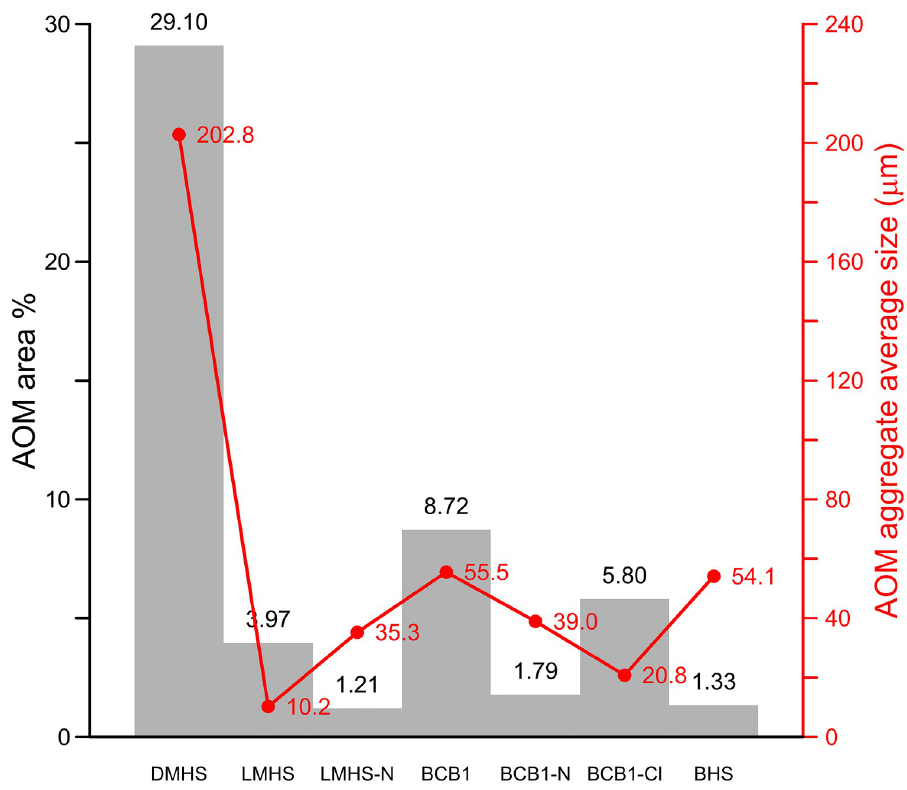
Fig 11. Amorphous organic matter content. Amorphous organic matter (AOM) content in DMHS, LMHS, BCB1, BHS, in the northern facies of LMHS (LMHS-N) and BCB1 (BCB1-N), as well as in a rip-up clast of BCB1 (BCB1-Cl) included in BHS. Quantity expressed as percentage of the whole microphotograph area (grey histogram) and aggregate size (red line), after extraction by decorrelation stretching using MathWorks MatLab R2019a, colour thresholding and particle measurement using ImageJ